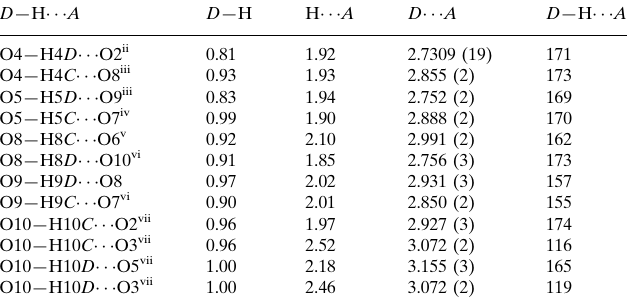
Hydrogen-bond geometry (A˚ , (cid:3)